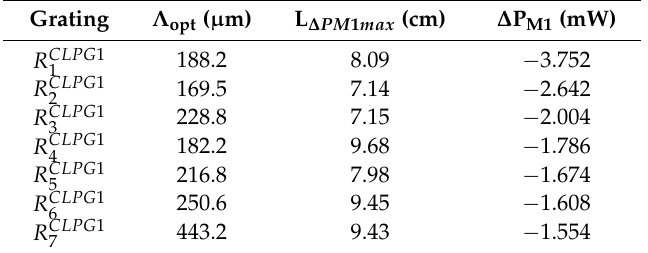
Table 5. Parameters of grating cascade CLPG 1 , grating length L ∆ PM 1 max separately